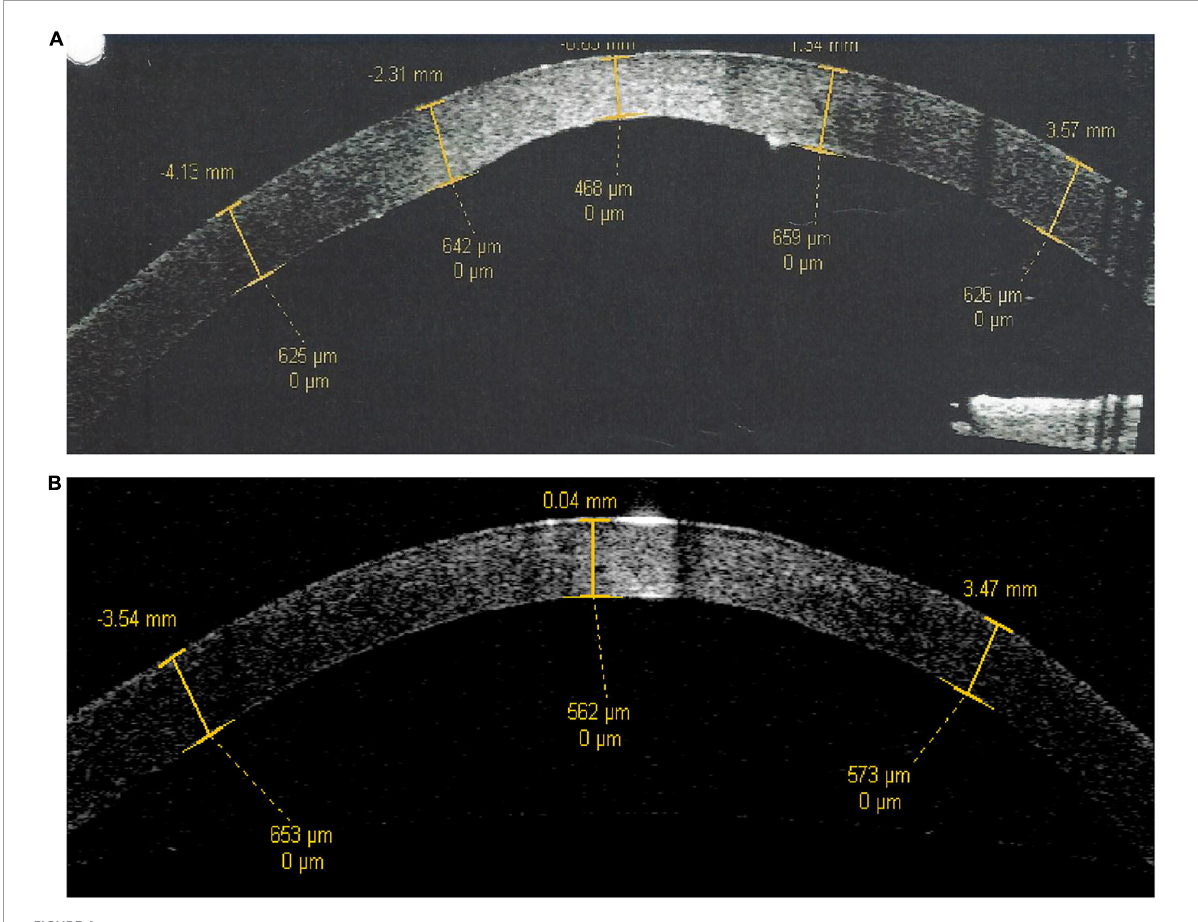
FIGURE4 Anterior segment optical coherence tomography scans of patient 2. (A) Right eye with type 1 Peters anomaly. (B) Left eye which is normal. There is a posterior corneal defect in the central cornea of the right eye, evidenced by a central corneal thickness of 468 µ m in contrast to a central corneal thickness of 562 µ m in the normal fellow